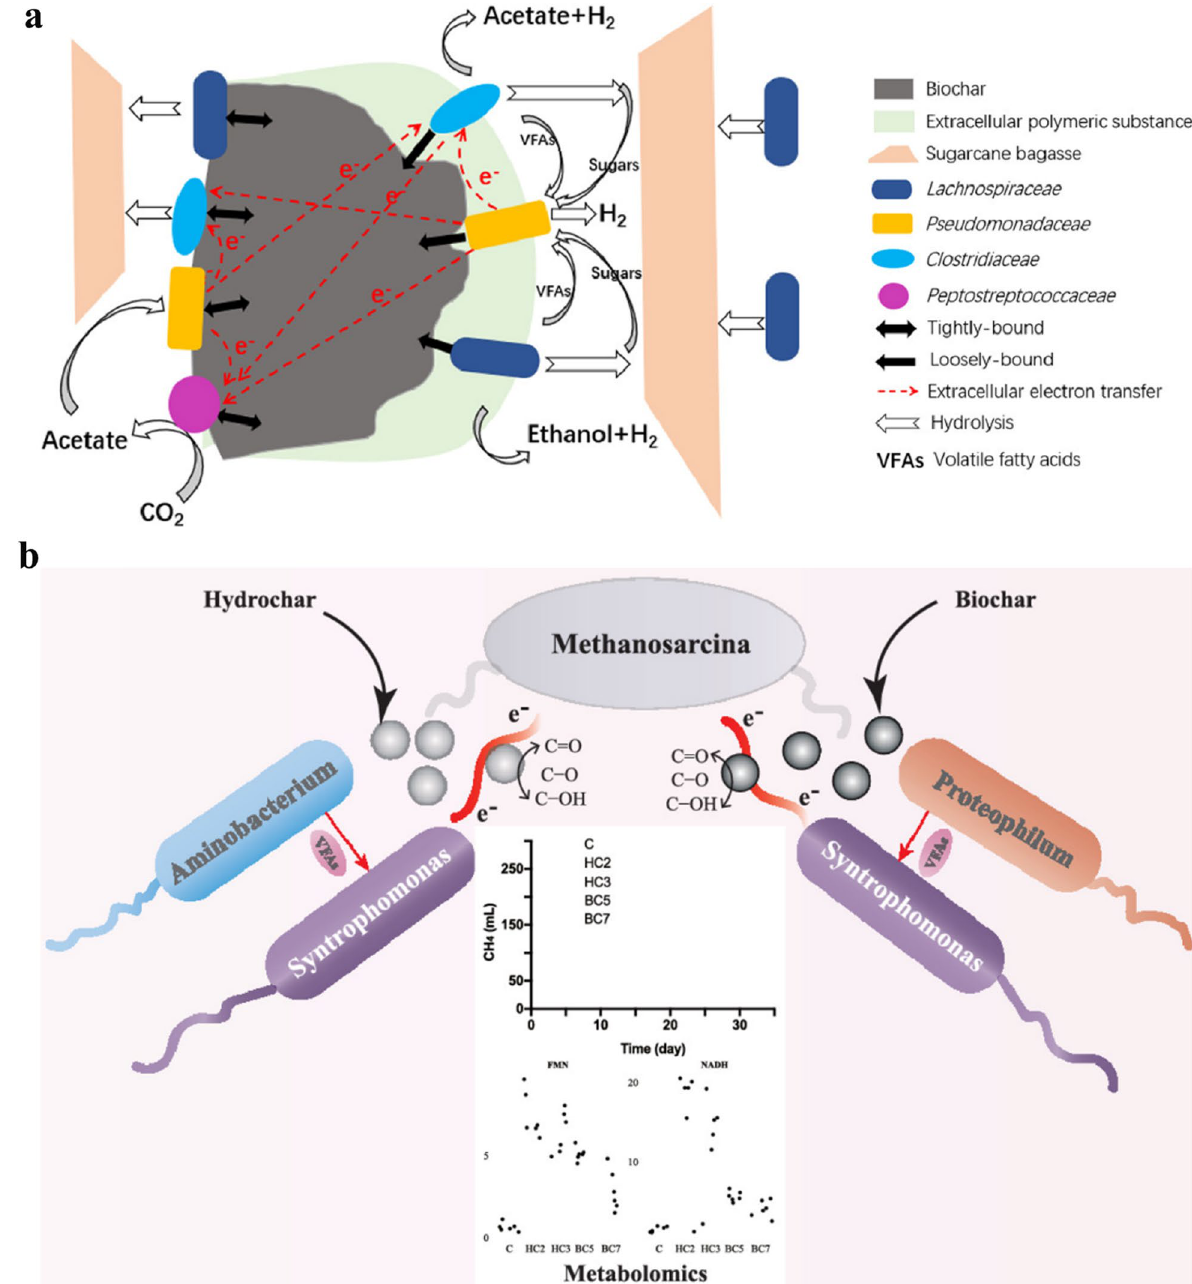
Fig. 6 Proposed schematic of dark fermentative hydrogen enhanced with biochar ( a ) (Bu et al. 2021); The anaerobic digestion of waste activated sludge promoted by hydrochar and biochar ( b ) (Shi et al.